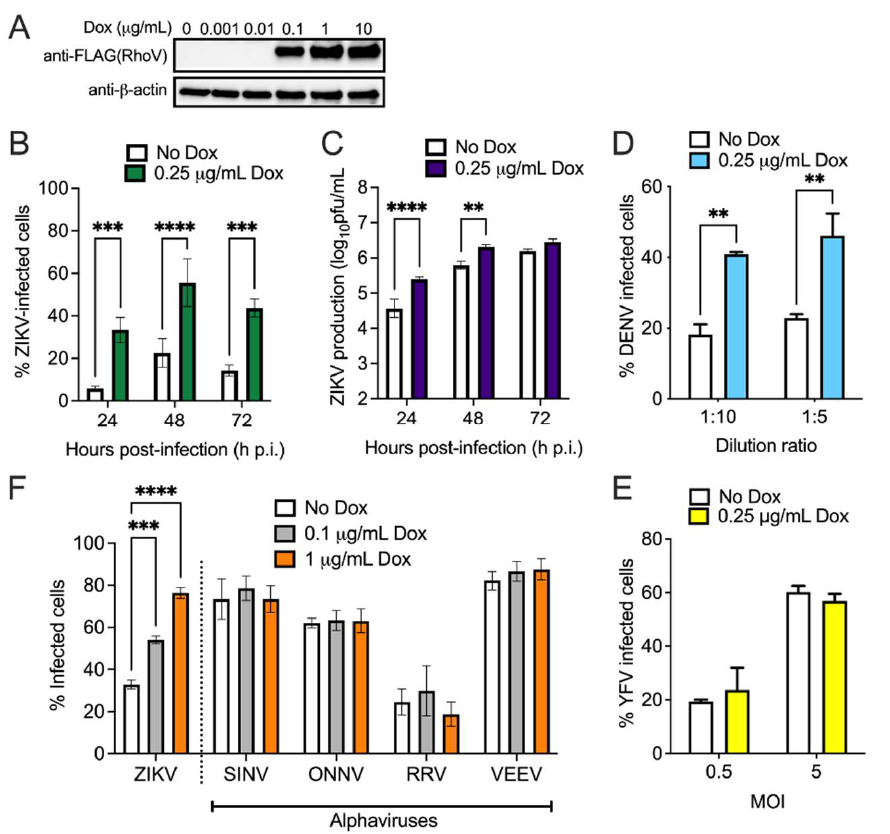
Figure 3. RhoV enhances ZIKV and DENV but not alphavirus infection in SNB-19 cells. ( A ) Inducible RhoV SNB-19 cells were treated with different amounts of Dox (0, 0.001, 0.01, 0.1, 1, and 10 µ g/mL) for 24 h to induce the expression of N-terminally 3xFLAG-tagged RhoV through the ePiggyBac trans- poson system. RhoV and β -actin (loading control) protein expression determined by immunoblotting with FLAG and β -actin antibodies. The data are representative of two independent experiments. ( B ) Inducible RhoV SNB-19 cells were treated with or without 0.25 µ g/mL Dox for 24 h prior to 1 h adsorption with ZIKV (MOI = 0.5 PFU/cell) and harvested at 24, 48, and 72 h.p.i. to quantify infection levels. Dox was added back to the media during the course of infection. ZIKV infected cells were then fixed and permeabilized to stain with the pan-flavivirus envelope antibody prior to flow cytometry analysis. The data are combined from two independent experiments. ( C ) Supernatant of infected cells from ( B ) was collected at the same timepoints and titered on Vero cells by plaque assay. The data are representative of two independent experiments. Inducible RhoV SNB-19 cells were treated with or without 0.25 µ g/mL Dox for 24 h prior to 1 h adsorption with ( D ) DENV-GFP (1:10 or 1:5 dilution) or ( E ) YFV 17D Venus (MOI = 0.5 or 5 PFU/cell) and harvested at ( D ) 72 h.p.i. or ( E ) 48 h.p.i. to quantify infection levels. Dox was added back to the media during the course of infection. YFV- and DENV-infected cells were fixed prior to flow cytometry analysis for GFP/Venus expression. The data are representative of two independent experiments. ( F ) Inducible RhoV SNB-19 cells were treated with 0.1 and 1 µ g/mL Dox 24 h prior to 1 h adsorption with ZIKV (MOI = 0.5 PFU/cell), and GFP-expressing SINV (MOI = 1 PFU/cell), ONNV (MOI = 1 PFU/cell), VEEV (MOI = 0.5 PFU/cell), and RRV (MOI = 5 PFU/cell) and harvested at 24 h.p.i. to quantify infection levels. Dox was added back to the media during the course of infection. ZIKV infected cells were then fixed and permeabi- lized to stain with the pan-flavivirus envelope antibody as above, while alphavirus-infected cells were fixed prior to flow cytometry analysis for GFP expression. The data are combined from two in- dependent experiments. Asterisks indicate statistically significant differences (two-way ANOVA